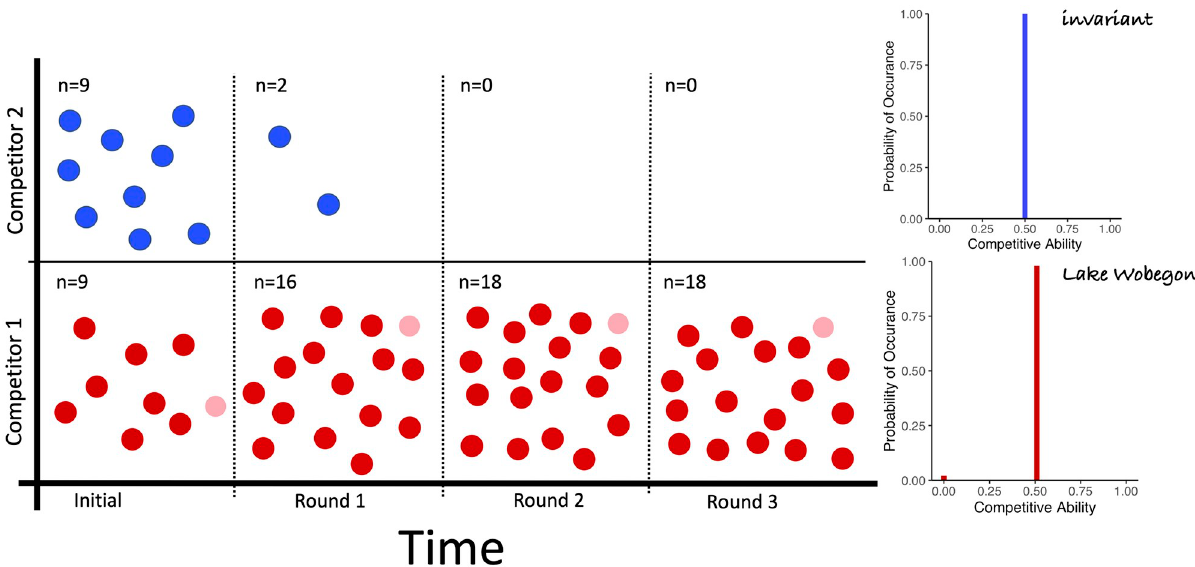
Fig 4. Phenotypic heterogeneity persists whereas invariability can be eliminated. Three rounds of competition are simulated for two strategies. Probability distributions of strategies are illustrated on the right with individuals (n) represented by color coded circles. Here the invariant strategy (top, blue), characterized by lack of variability and a constant competitive ability equal to the mean, is eliminated by the Lake Wobegon strategy (bottom, red), characterized by one individual with 0 competitive ability and all others are ‘above average’ (mean+x for a small x > 0). This and the following figures show few individuals for clarity but simulations utilized larger sample sizes for accurate representation of the probability distributions of competitive abilities.